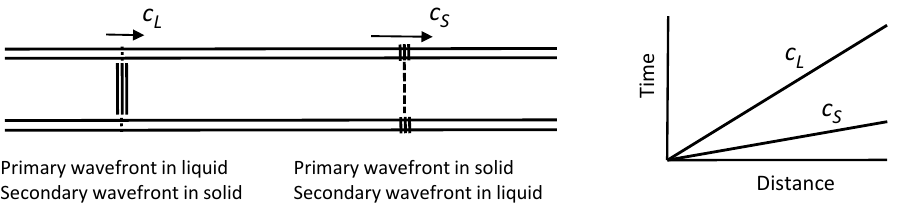
Figure 5. Wave pair in fluid – structure interaction.